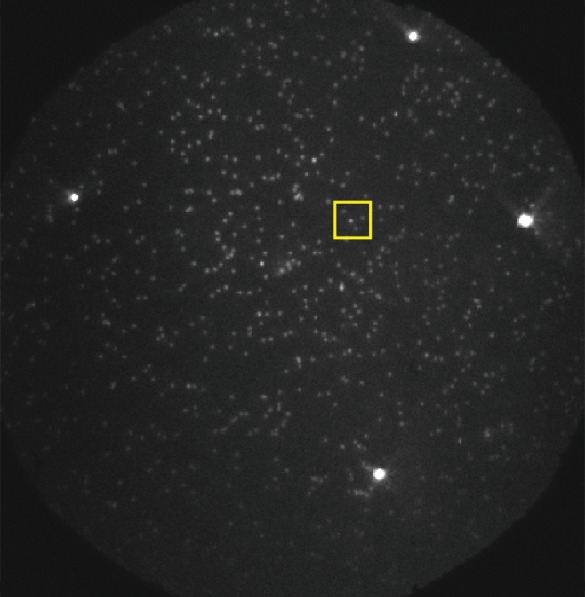
Rastergrams of each subcomplex binding to 50 randomly selected 'no RNA' control locations.Data are from the experiments shown in Figure 2. The stated fraction (±s.e.) of the no RNA locations that exhibited subcomplex binding was calculated from the total sample of N no RNA locations reported in Figure 2F.